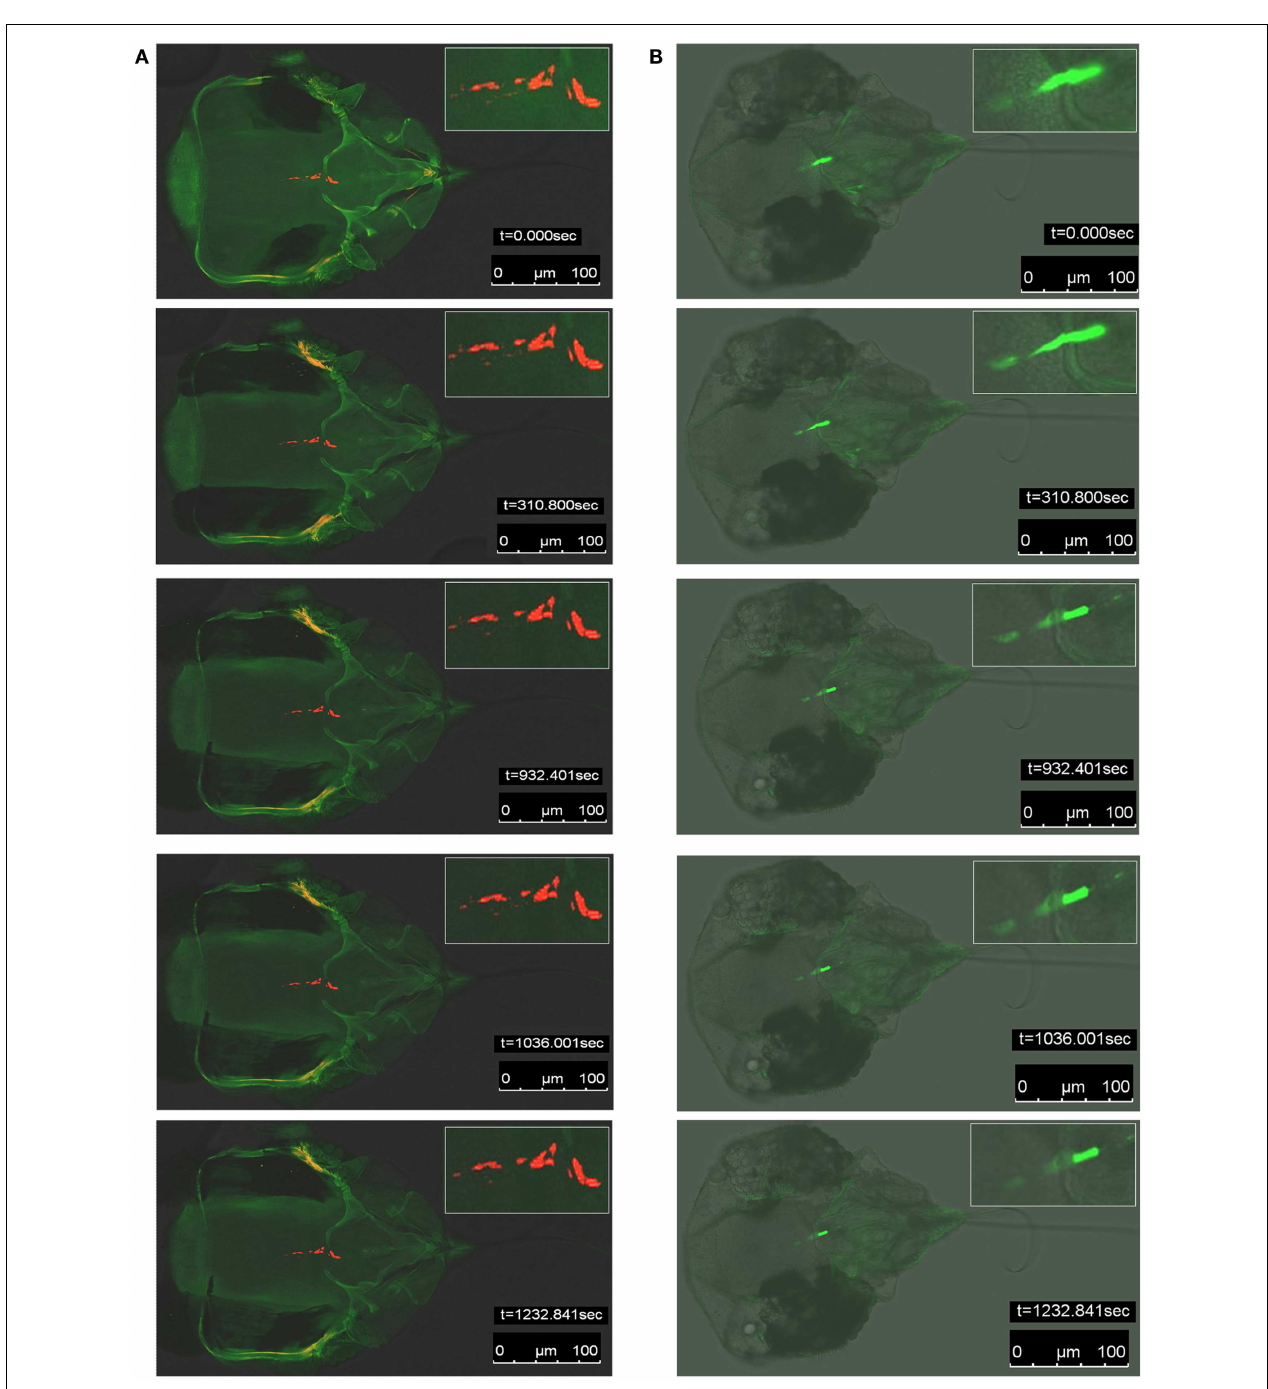
photobleaching in Alexa Fluor 488-immunofluorescent labeled (green signals) whitefly vectors fed artificial diet augmented with LIYV virions, anti-LIYV virion IgG, and Alexa Fluor 488-conjugated goat anti-rabbit IgG.The Inset in each snapshot is an enlarged image of the region in which QD or Alexa Fluor signals were detected.The time intervals ( t = 0.000, 310.800, 932.401, 1036.001, 1232.841s) at which snapshots were taken and bars representing 100 µ m are indicated in each